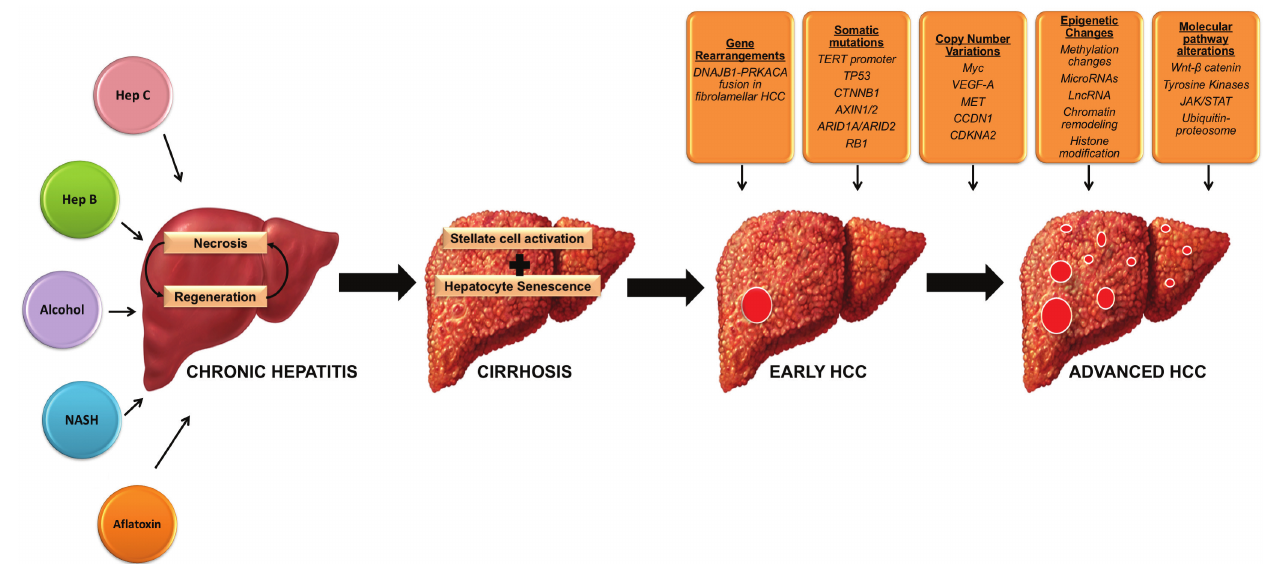
Figure 2. Pathogenesis of Hepatocellular Carcinoma. Chronic exposure of the liver to injury from viral hepatitis, alcohol abuse or NASH causes repeated hepatocyte damage and sets up a vicious cycle of cell death and regeneration which eventually results in cirrhosis. The resultant genomic instability leads to initiation of HCC. Step wise accumulation of multiple genetic events including gene rearrangements, somatic mutations, copy number alterations, epigenetic changes and growth factor pathway alterations eventually lead to tumor progression and metastases. Abbreviations: Hep B, hepatitis B; Hep C, hepatitis C; HCC, hepatocellular carcinoma; NASH, non-alcoholic